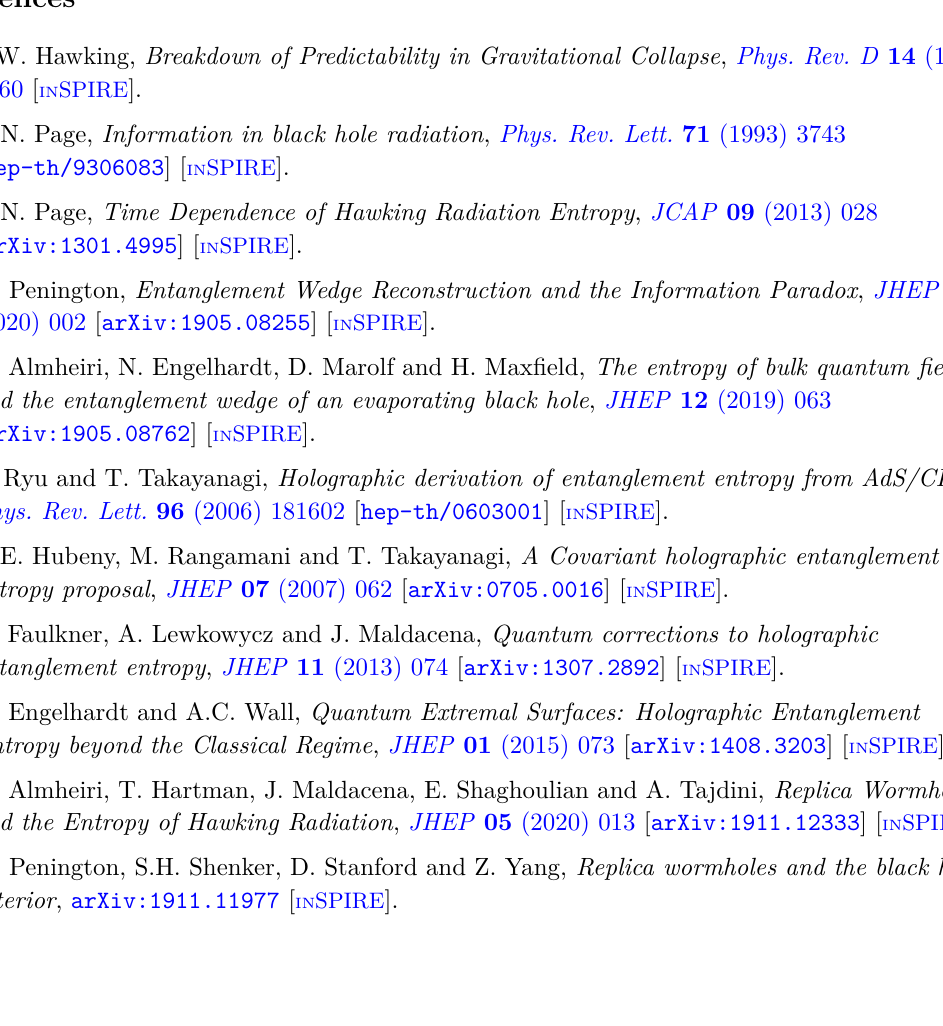
) with respect to time T for d = 4 , X 0 = 0 . 1 and 4 G ( d +1) N L d − 2 d − 2 (cid:15) d − 2